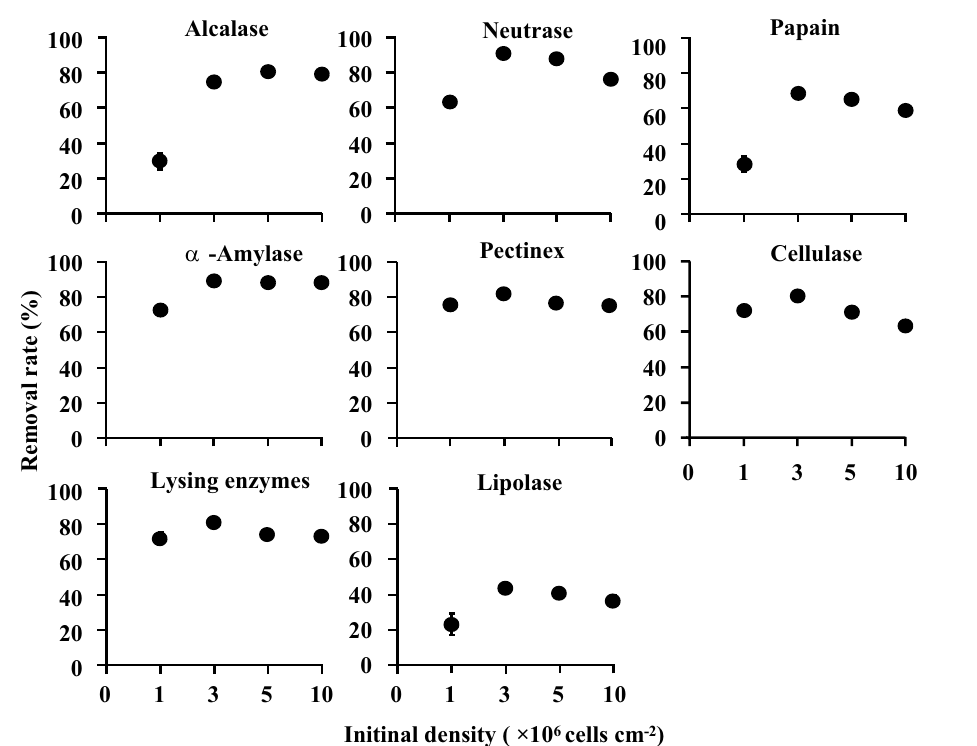
Figure 3. Removal rate on S. marisflavi biofilm with different enzyme